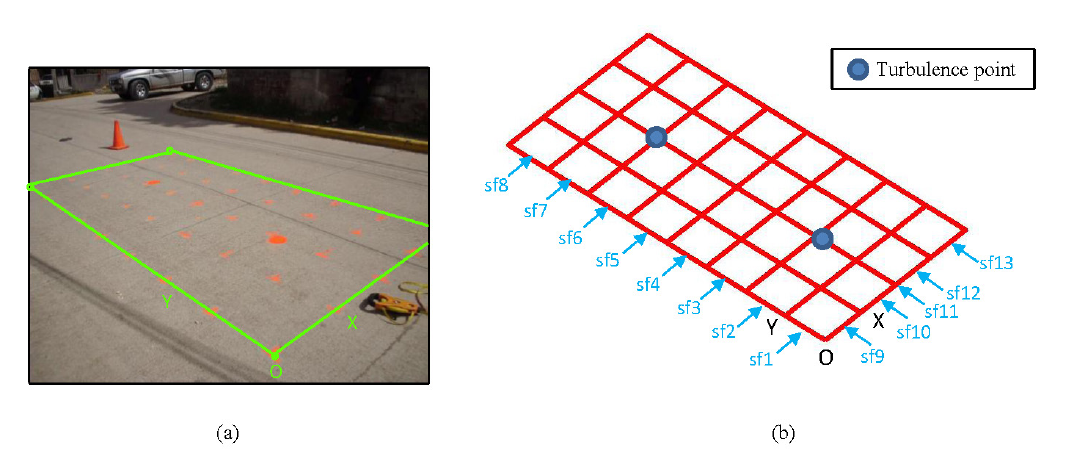
Figure 21. Layout for the fieldwork.